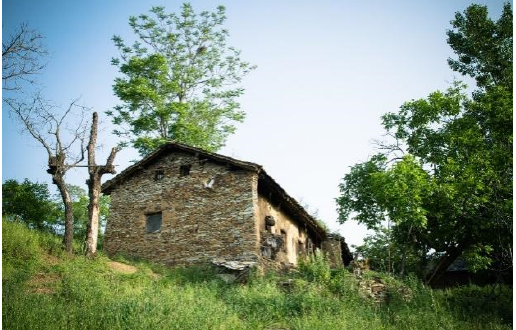
Figure 5. The typical example of the traditional slate dwellings.